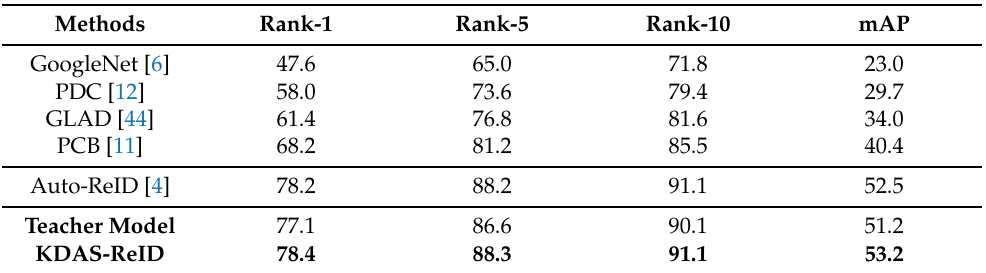
Table 4. Comparison of accuracy and mAP with the state-of-art reID models on MSMT17. We have boldfaced the best results in the